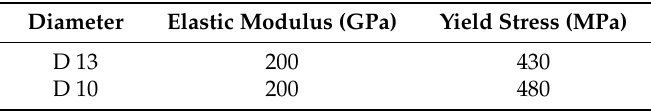
Table 5. Mechanical properties of reinforcement used in RC member.